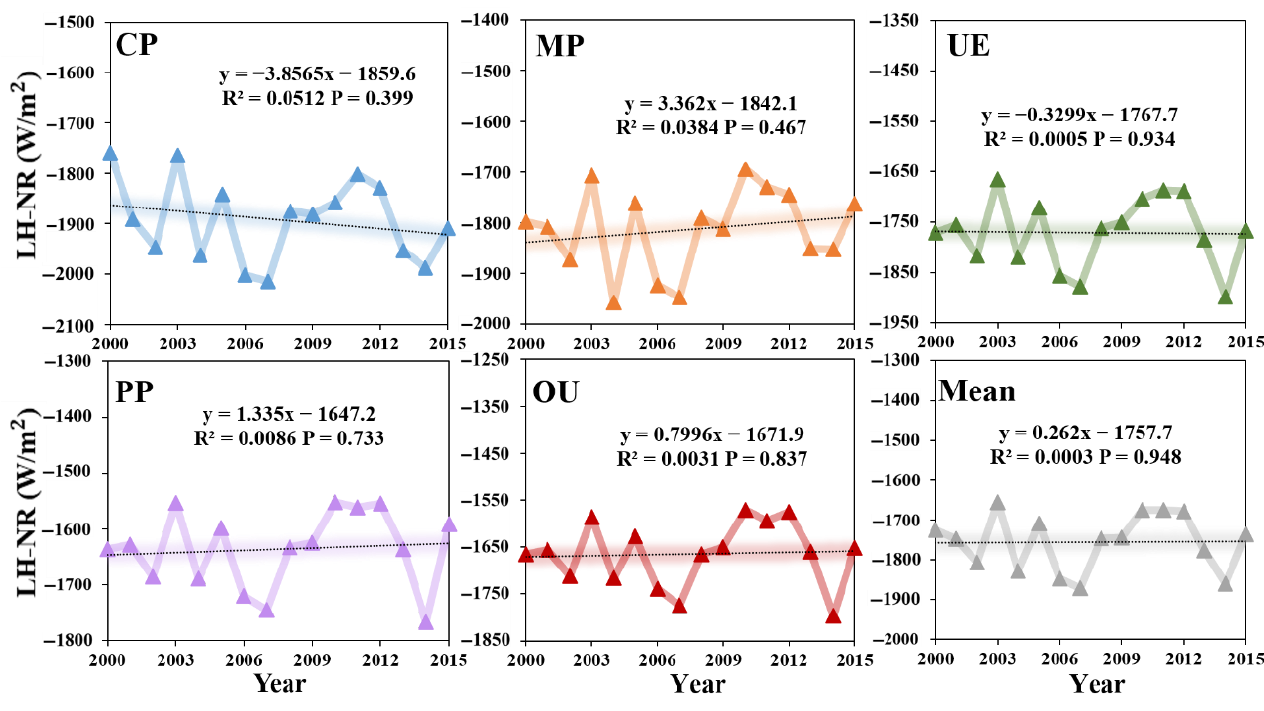
Figure 13. Variation trends of net radiation ( LH − NR ) under different land use types in the Huang- Huai-Hai River Basin from 2000 to 2015.